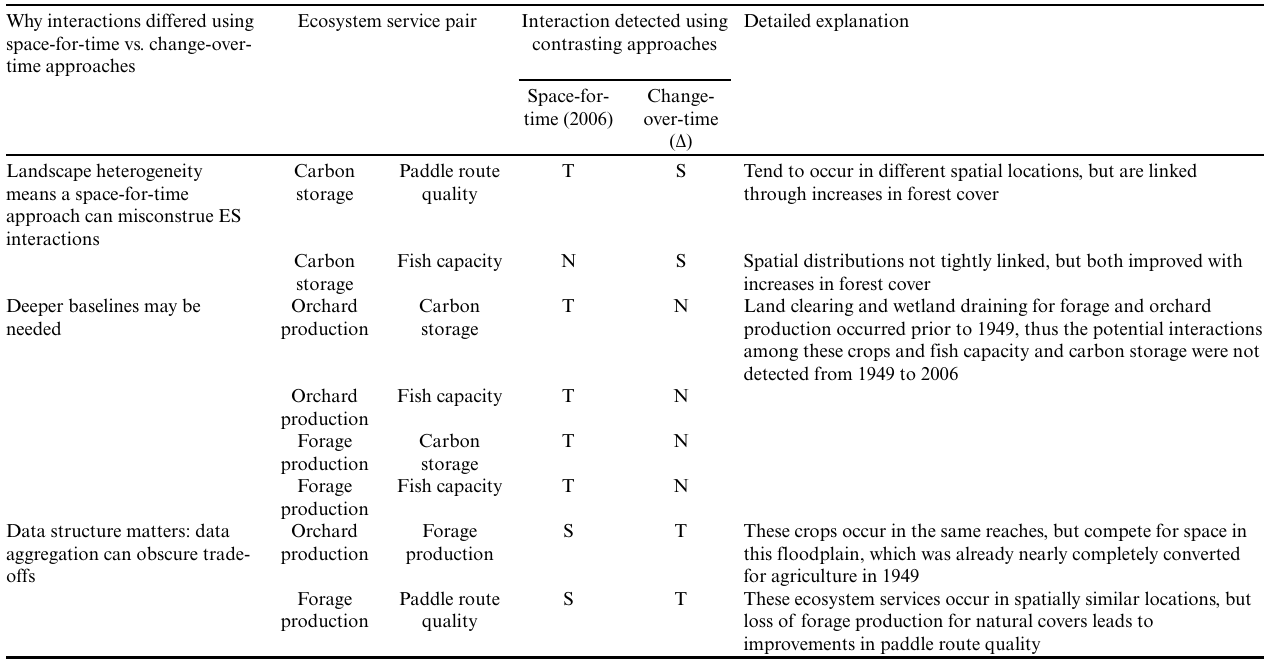
Table 4 . Primary issues resulting in differing results in space-for-time vs. change-over-time approaches for identifying ecosystem service